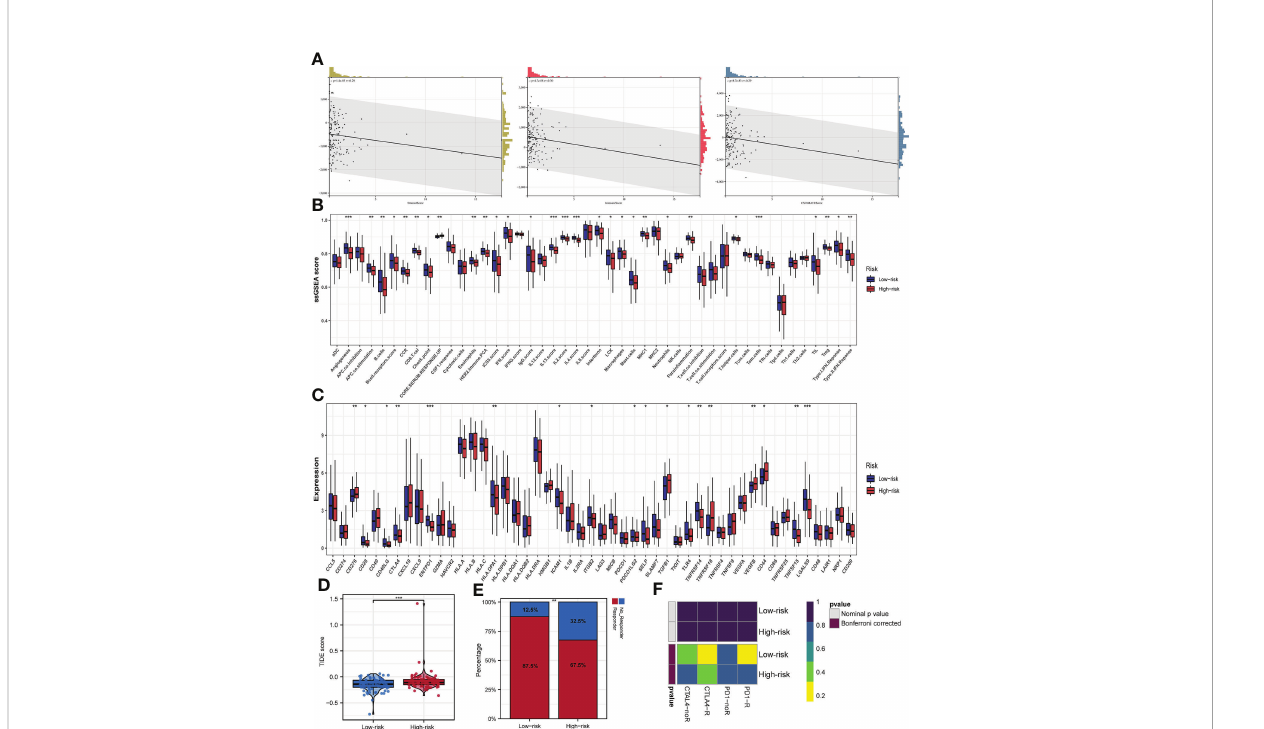
FIGURE 8 Immune in fi ltration and prognostic signi fi cance of m6A-associated lncRNAs in EC patients. (A) Risk score value is related to stromal score, immune score, and estimate score. (B) In fi ltrations of immune cells and immune function quanti fi ed by the ssGSEA Z-score among patients with EC. (C) The expression status of common immune checkpoints between subgroups with high- and low-risks. (D) TIDE score between the two subgroups. (E) The distribution of immunotherapeutic responses between the two subgroups. (F) Subclass mapping algorithm between immunotherapy-responding patients and EC patients in two subgroups *p<0.05; **p<0.01;